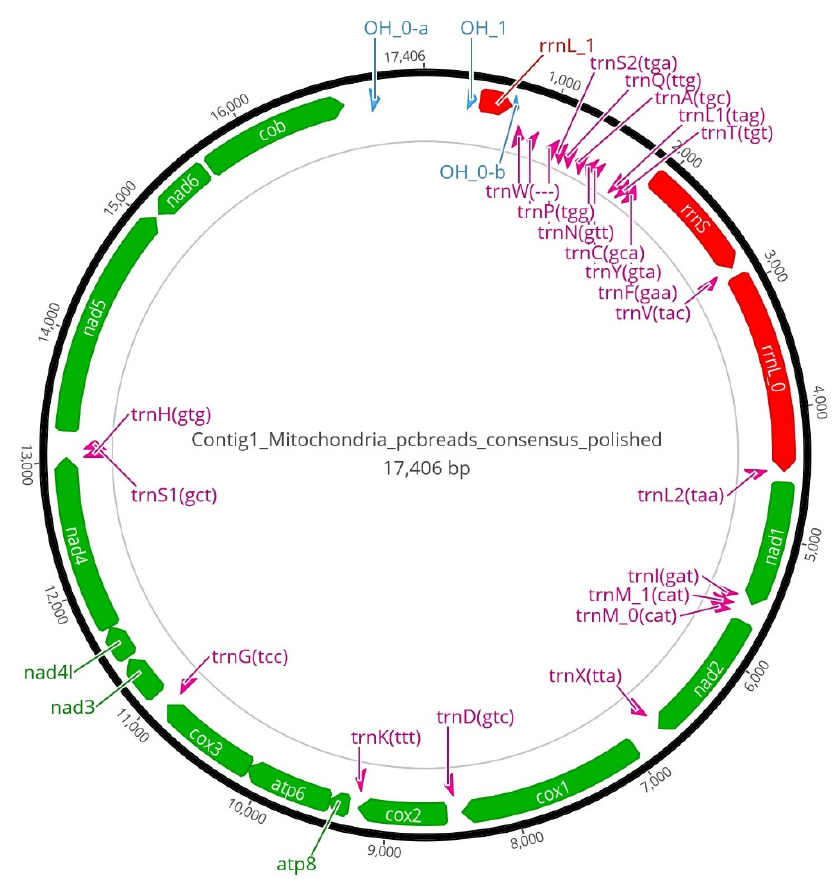
Figure 15. Results of K-mer analysis. See text for details.